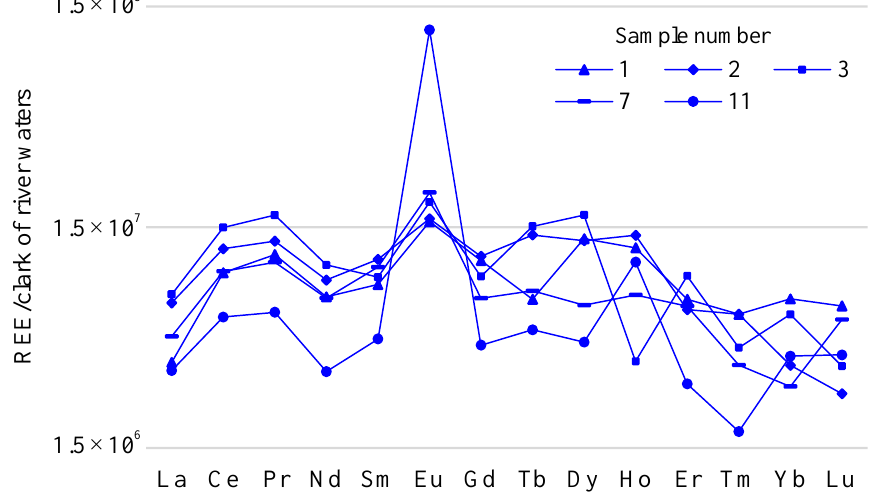
Figure 6. Spectra of REEs in lake water within Burabay District (chondrite is normalized).